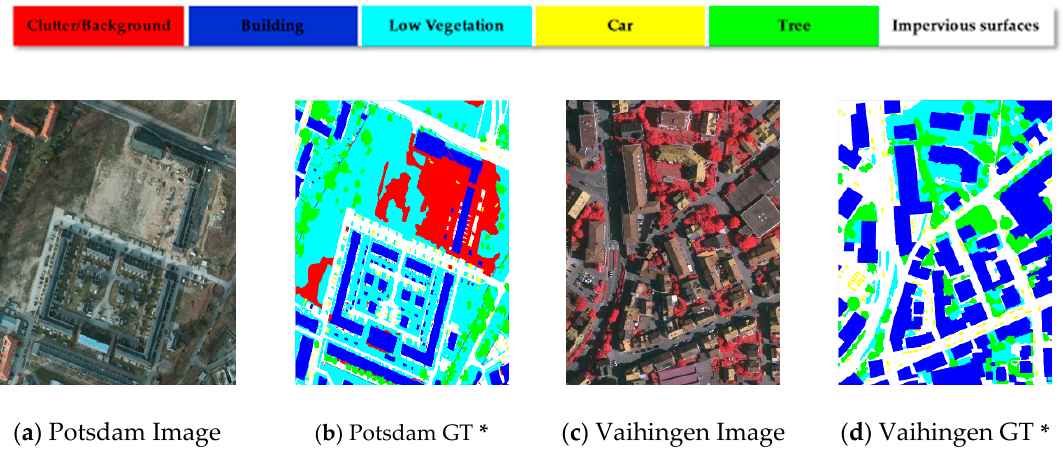
Figure 8. Images and Ground Truth of Potsdam and Vaihingen Datasets ( * GT: ground truth).